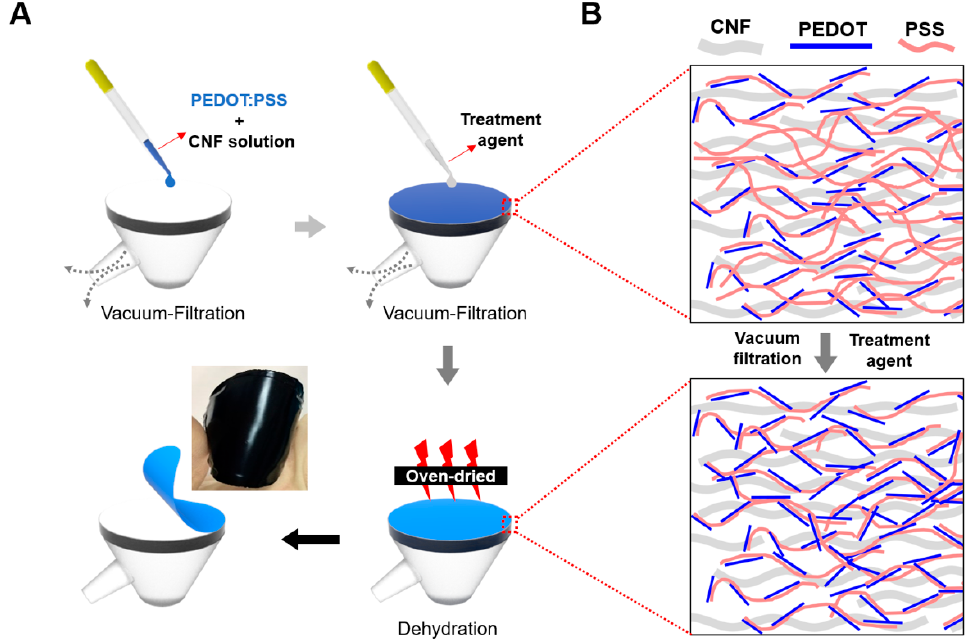
Figure 1. ( A ) Schematic illustration of the fabrication of post-treated poly(3,4- ethylenedioxythiophene)-poly(styrenesulfonate) (PEDOT:PSS)/CNF composite paper using a vacuum-filtration process with different treatment agents. ( B ) Morphological changes in the PEDOT:PSS/cellulose-nanofiber porous composite film through post-treatment involving the addition of organic solvents.